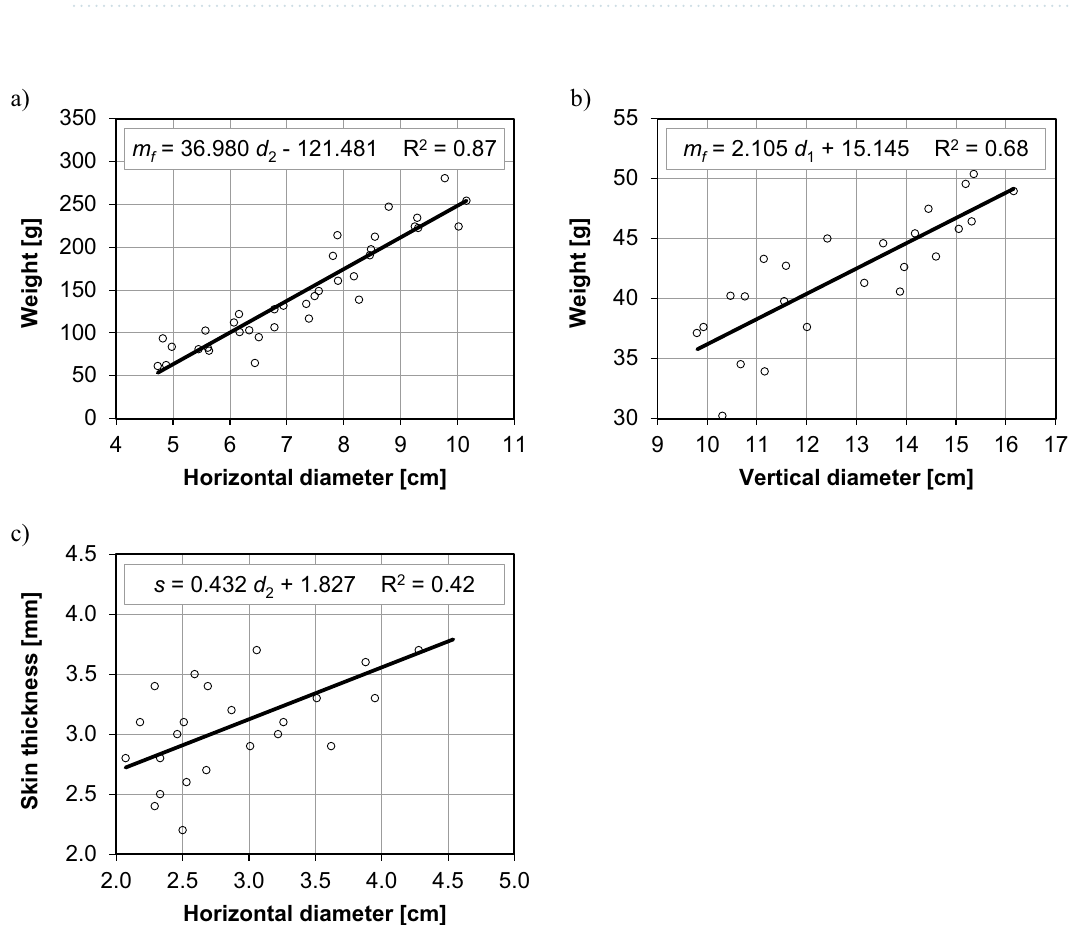
Figure 1. Relationships between the biometric parameters of Capsicum annuum fruit: ( a ) horizontal diameter and weight of sweet peppers, ( b ) vertical diameter and weight of hot peppers, ( c ) horizontal diameter and skin thickness of hot